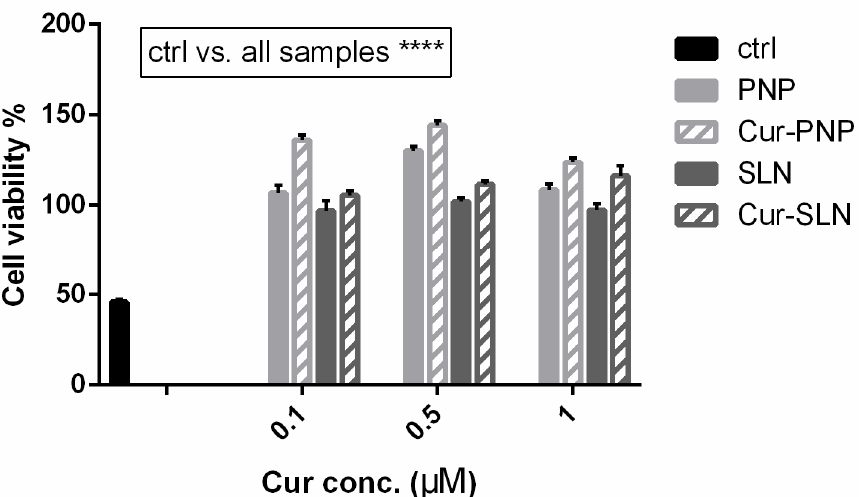
Figure 4. Cell viability after exposure for 24 h of hypoxic OECs to Cur-PNP and Cur-SLN at different concentrations. Significance was defined as **** p < 0.0001.